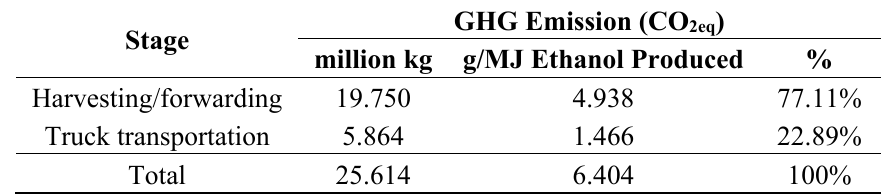
Table 6. Emissions for harvesting and truck transportation stages.